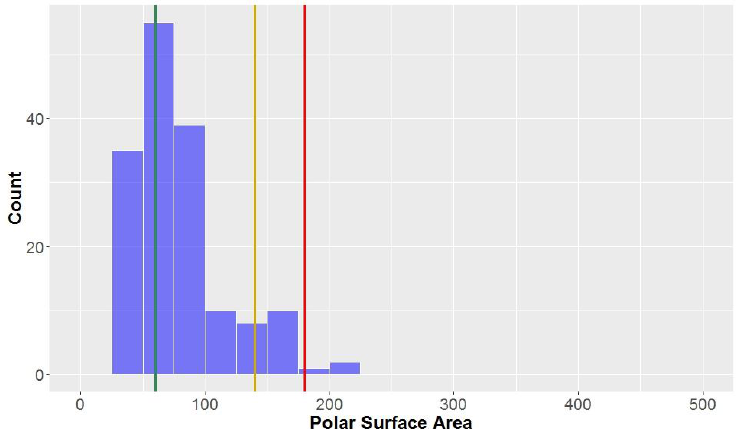
Figure 7. The statistical distribution of the polar surface area (PSA) of all analysed compounds (green = 60, compounds < 60 Å 2 are in the lead-like space; yellow = 140, compounds < 140 Å 2 are in the drug-like space; red = 180, compounds < 180 Å 2 are in the KDS). Total number of compounds = 160.